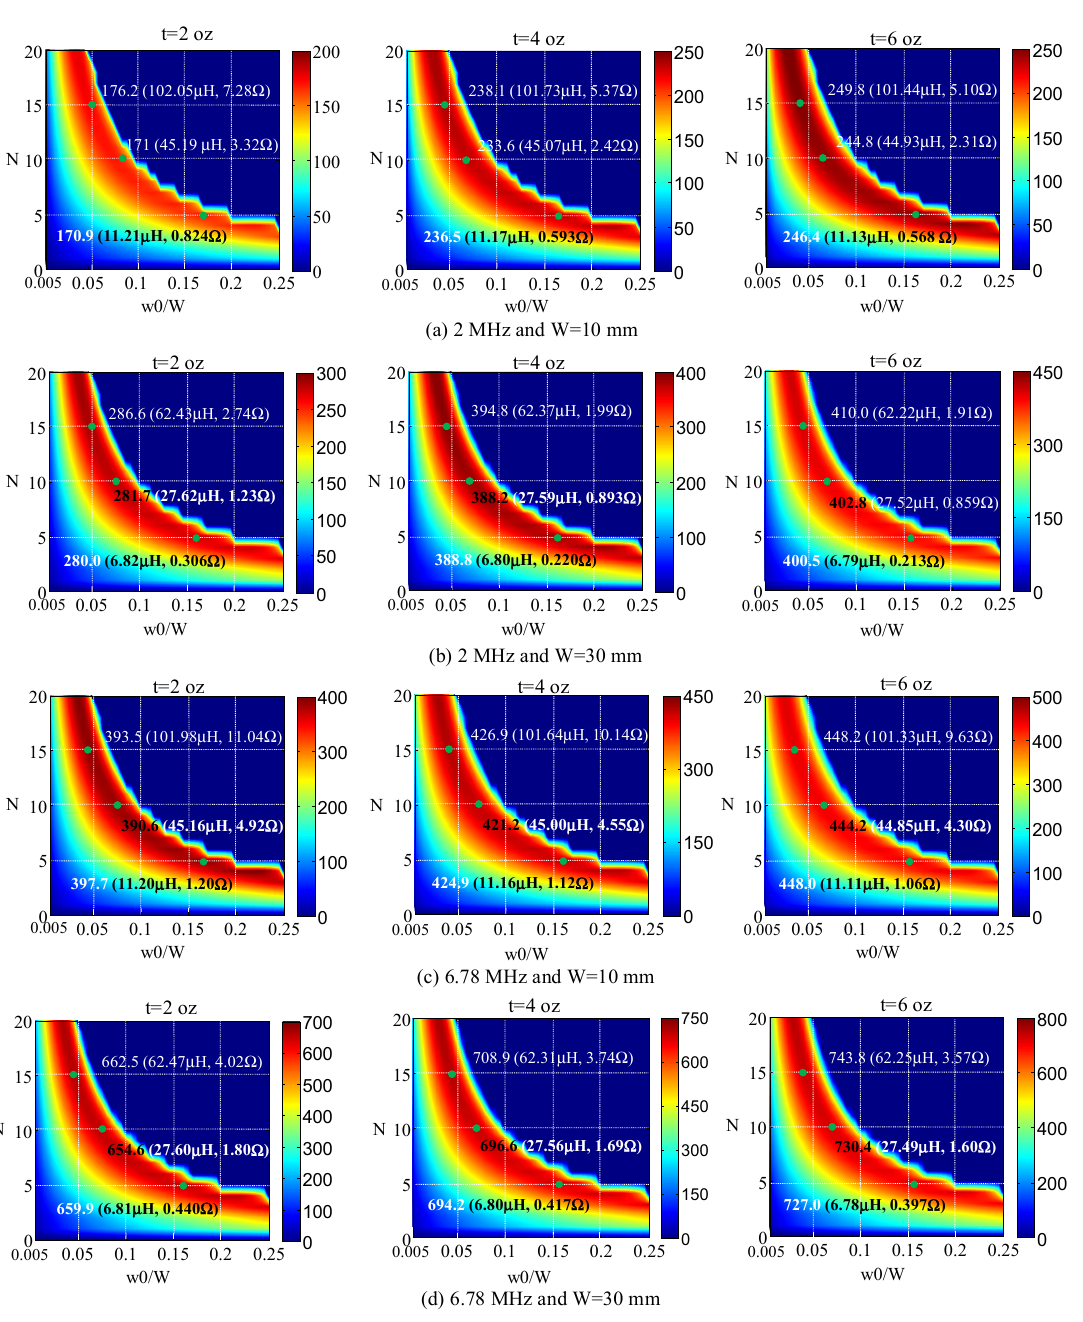
(d) 6.78 MHz and W=30 Figure 6. Calculated Q-factors according to 2 ≤ N ≤ 20 and 0.005 ≤ w 0/ W ≤ 0.25 for frequencies of 2 MHz and 6.78 MHz, W = 10 mm and 30 mm, and pattern thickness of 2 oz, 4 oz, and 6 oz. According to the turn numbers, the maximum Q-factor changed little in all cases. This finding indicates that a turn number can be derived for self-inductance, which is necessary for a WPT system, and an optimal w 0/ W can then be obtained for the maximum Q-factor and maximum coupling